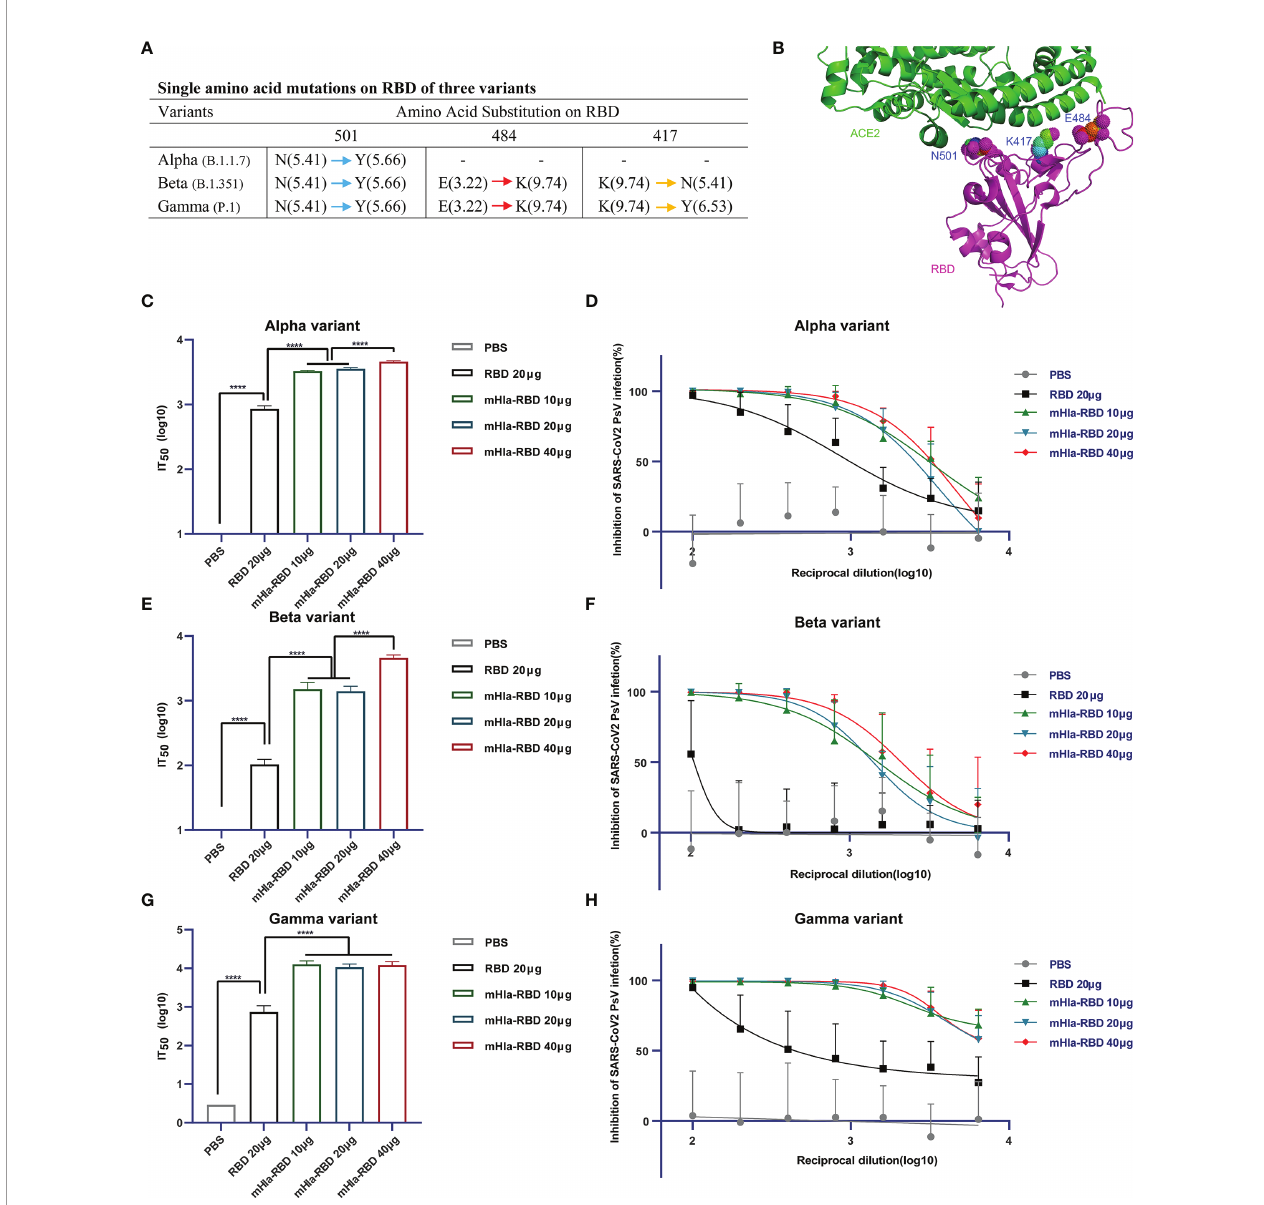
FIGURE 6 | Cross-neutralization ef fi cacy. (A) Details of key amino acid mutations in the RBD of three variants (N, asparagine; Y, tyrosine; E, glutamic acid; K, lysine). Values in brackets present the isoelectric point (pI) of amino acids. Red arrow means a signi fi cant change in pI. Yellow arrow means middle extent of change in pI. Blue arrow means minor change in pI. (B) Structural presentation of key amino acid mutations in the RBD of three variants (PDB: 6M0J). (C) Alpha-variant pseudovirus neutralization assay. Two-tailed unpaired Student ’ s t-test, **** p < 0.0001. (D) Inhibition of alpha-variant pseudovirus infection by serial dilution of sera from immunized Balb/c mice. (E) Beta-variant pseudovirus neutralization assay. Two-tailed unpaired Student ’ s t-test, **** p < 0.0001. (F) Inhibition of beta-variant pseudovirus infection by serial dilution of sera from immunized Balb/c mice. (G) Gamma-variant pseudovirus neutralization assay. Two-tailed unpaired Student ’ s t- test, **** p < 0.0001. (H) Inhibition of gamma-variant pseudovirus infection by serial dilution of sera from immunized Balb/c